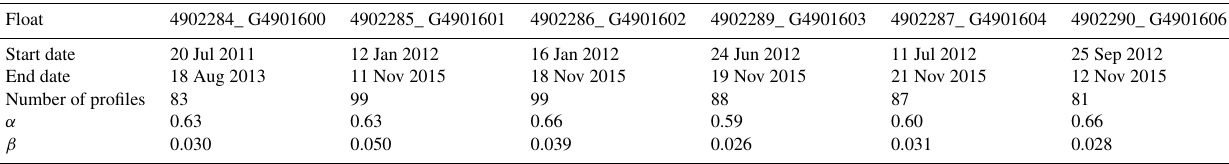
Table 1. Practical information about float mission and α and β coefficients values used for the calibration of fluorescence profiles measured by APEX